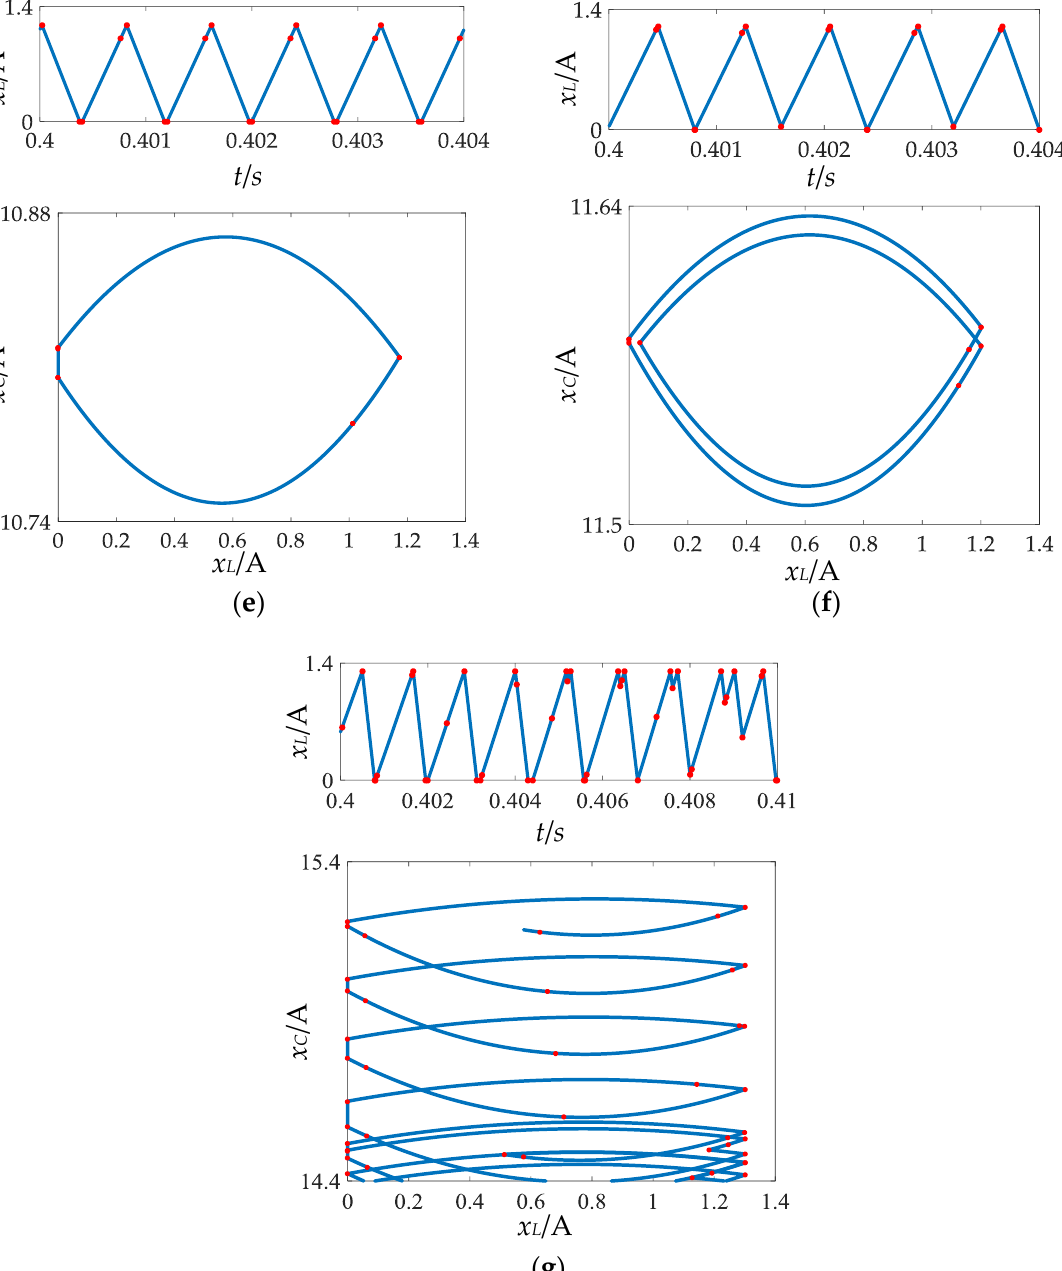
Figure 11. Waveforms of inductor current x L and phase plane at ( a ) I ref = 0.20 A; ( b ) I ref = 0.50 A; ( c ) I ref = 0.85 A; ( d ) I ref = 1.00 A; ( e ) I ref = 1.17 A; ( f ) I ref = 1.20 A; and ( g ) I ref = 1.27 A. In (a) to (g), x C and x L represent the inductor current and capacitor voltage, respectively, and the red marker dot corresponds the mode switching moment.